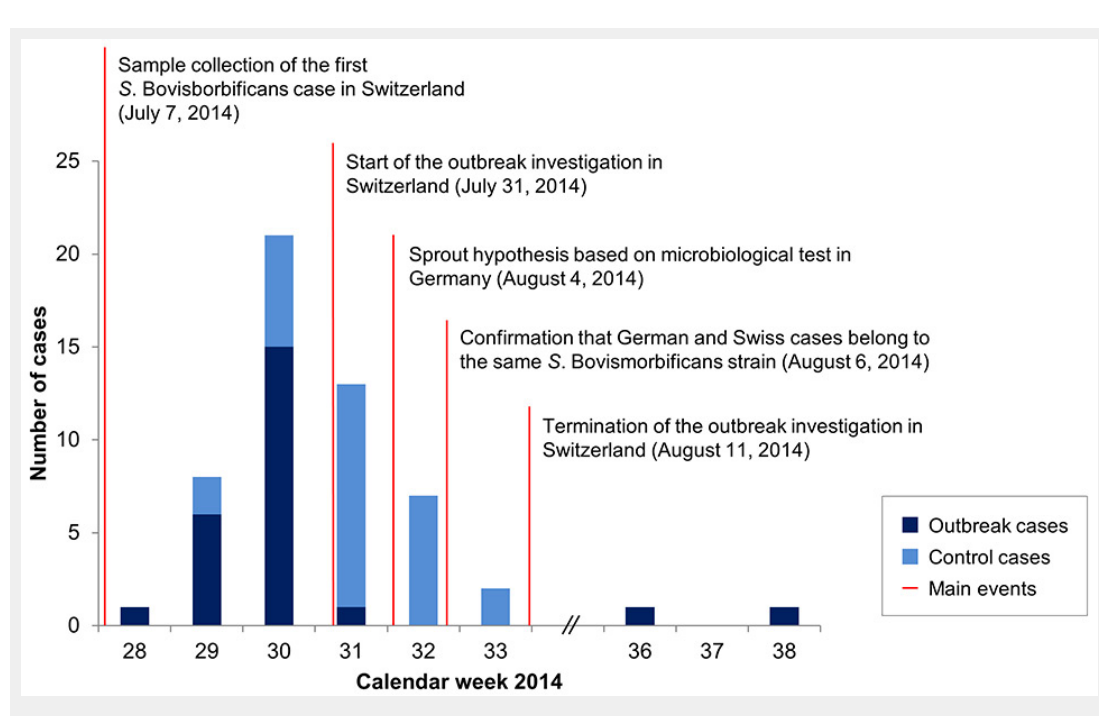
Epidemiological profile and main investigation events for the Salmonella Bovismorbificans outbreak, July–September 2014, Switzerland.